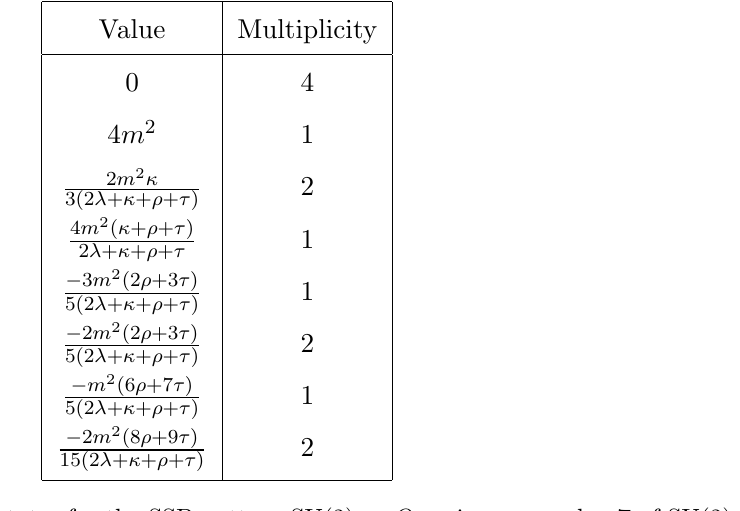
Table 4 . Scalar mass eigenstates for the SSB pattern SU(2) ! Q 6 using a complex 7 of